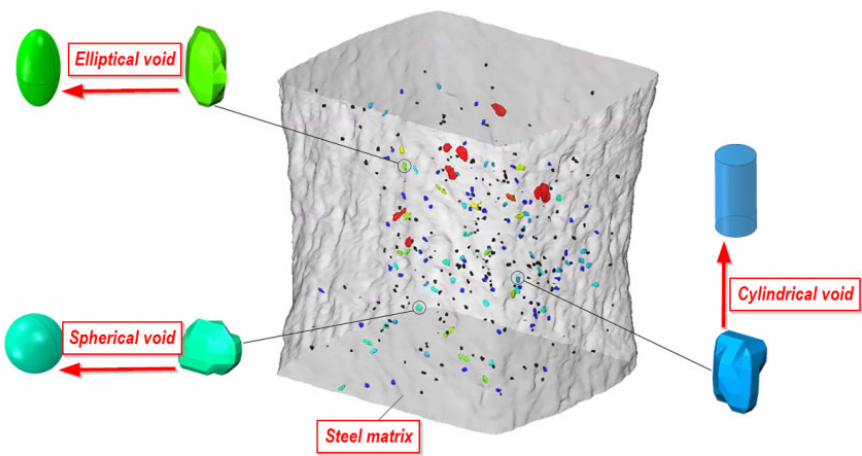
Figure 15. Shapes of voids in the material determined using computed tomography techniques (for structural steel) [124]. structural steel)